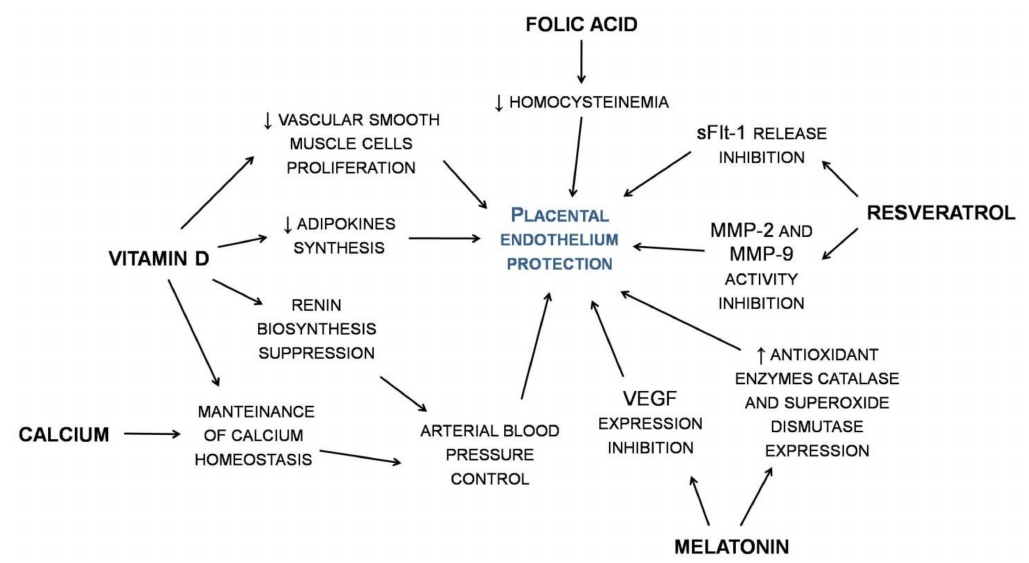
Figure 1. Selected bioactive compounds with demonstrated blood pressure lowering e ff ects in hypertensive disorders in pregnancy. MMP—matrix metalloproteinase; sFIt1—soluble fms-like tyrosine kinase-1; VEGF—vascular endothelial growth